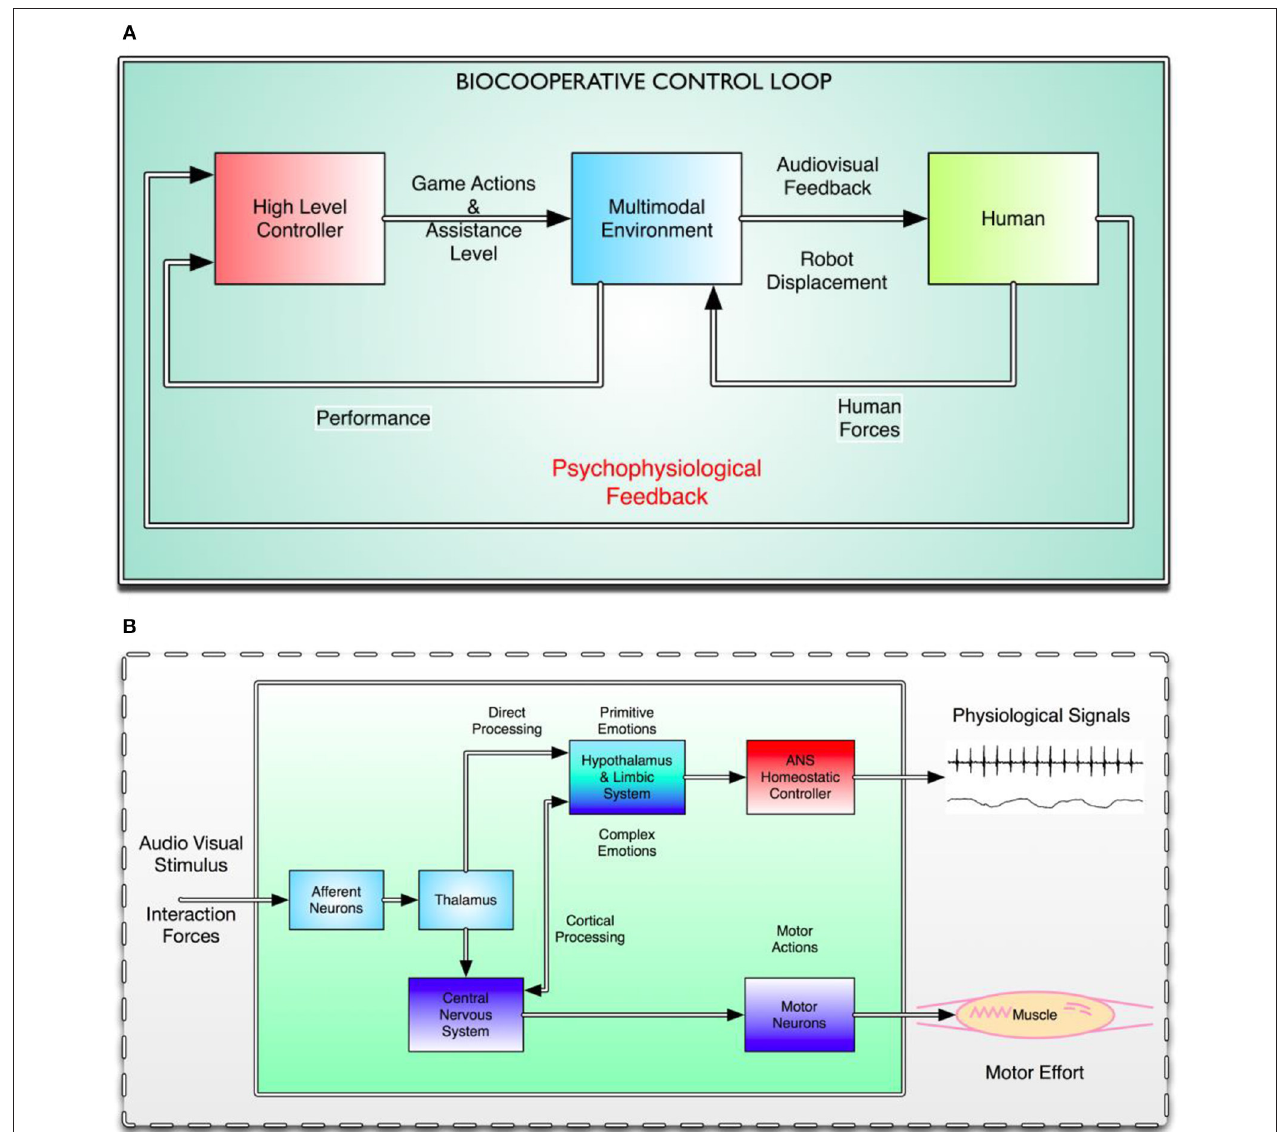
FIGURE 1 | (A) Macro view of the biocooperative control loop. Three different interacting blocks can be distinguished. From left to right, the red block represents the high-level controller, which makes decisions based on the overall state of the system, including the subject, and sends actions regarding the difficulty of the game and the level of haptic assistance to the multimodal environment represented by the central blue block. The yellow block represents the human, whose responses to the audiovisual and haptic feedback generate ANS responses and interaction forces, which are, in turn, used to close the biocooperative loop. (B) Effects of the multimodal interface (i.e., PHYSIOBOT and VR) on the human control system. External stimuli are captured by the afferent neurons in the peripheral nervous system (PNS) and distributed over different cortical and subcortical levels to the CNS: the thalamus, the limbic system, and the cortex. All external sensory input is received by the thalamus, which sends information simultaneously to the cortex for higher-level processing, and directly to the limbic system (LeDoux, 1995). Part of the information goes to the hypothalamus, which secretes neurohormones that either stimulate or inhibit the secretion of the pituitary hormones that modulate the behavior of the ANS. Simultaneously, the external stimuli make their way to the sensorimotor cortex, which modulates ongoing movements and motor effort, and the prefrontal cortex, which controls the subject’s psychophysiological state and turns it into a conscious state and thus a mood or feeling. ANS signals are then fed to the high-level controller and the interaction forces are fed to the multimodal environment as “human in the loop” feedback signals.